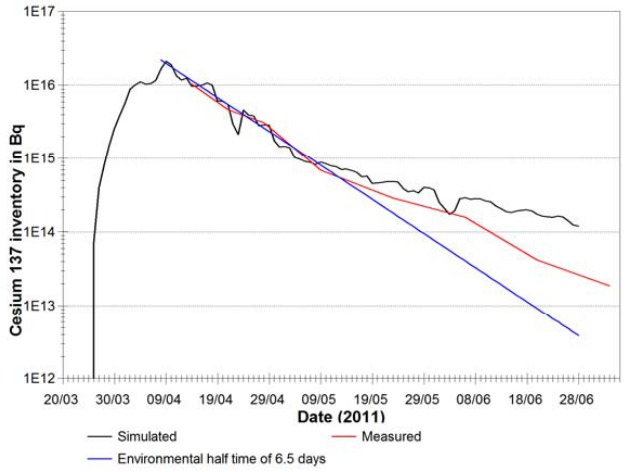
Figure 20. Time evolution of measured and simulated 137 Cs inventories present in the Fukushima area, adapted from [27].